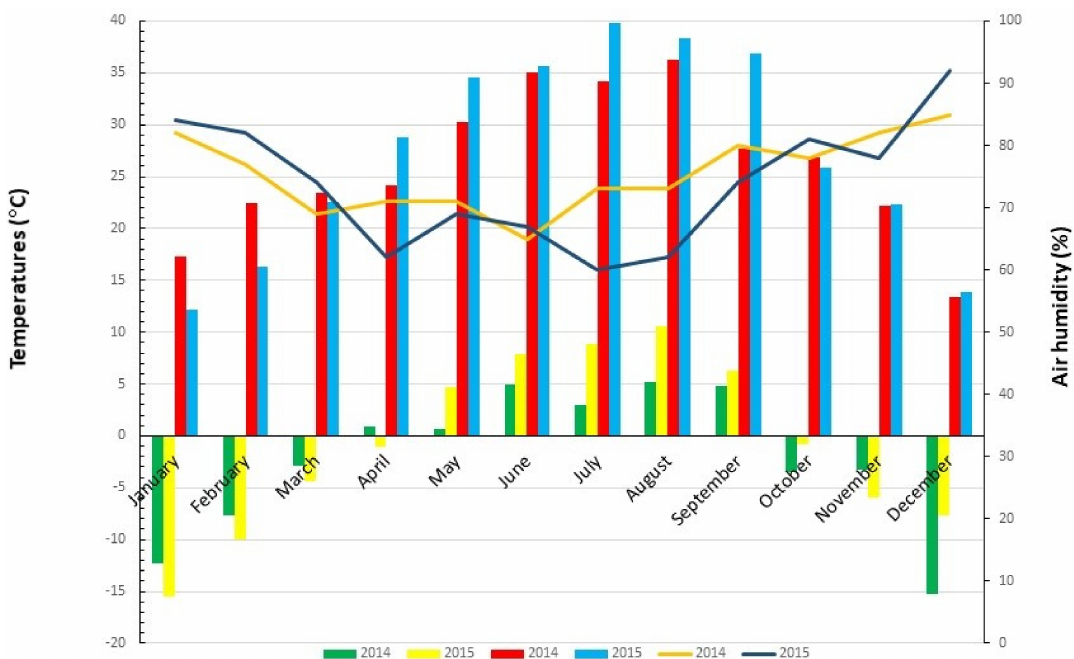
Figure 2. The temperatures (min, max; bars) and the air humidity (lines) during the two experimental seasons